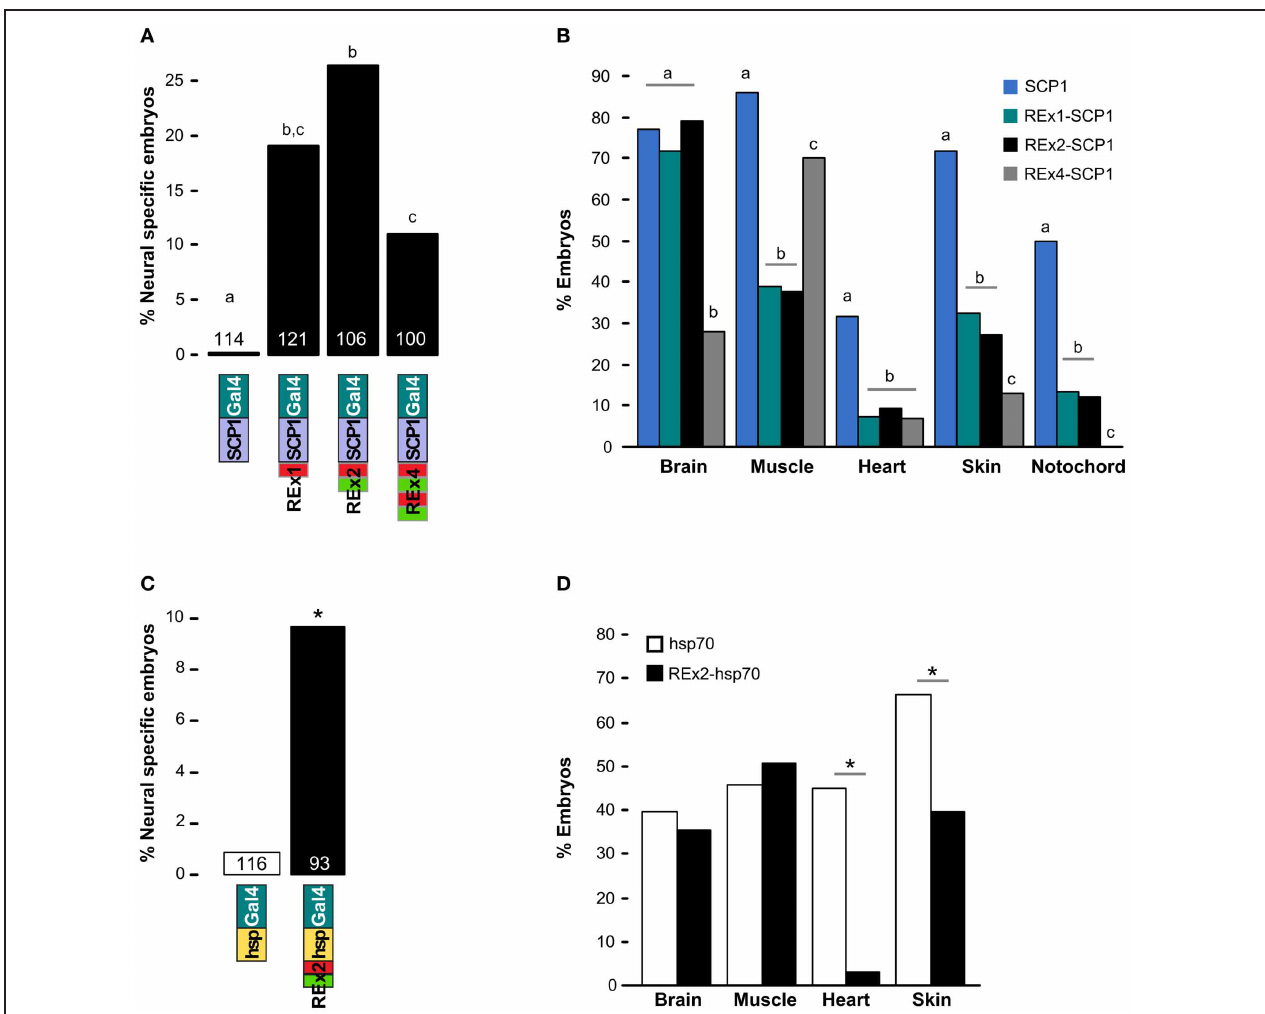
after injection with SCP1:Gal4 (blue), REx1-SCP1:Gal4 (green), REx2-SCP1 (black) and REx4-SCP1 (gray) plasmids. N is for the cognate construct in (A) . Letters show post-hoc tests for multiple proportions for each tissue type, p < 0 . 05 where letters differ. (C) and (D) Transient expression of hsp70:Gal4ff (white bars) and REx2-hsp70:Gal4ff (black bars) plasmids. (C) Percentage of embryos with reporter expression only in brain or spinal cord and number of embryos examined for each construct. ∗ p < 0 . 005. (D) Percentage of embryos with any expression in the indicated tissues. ∗ p < 0 .